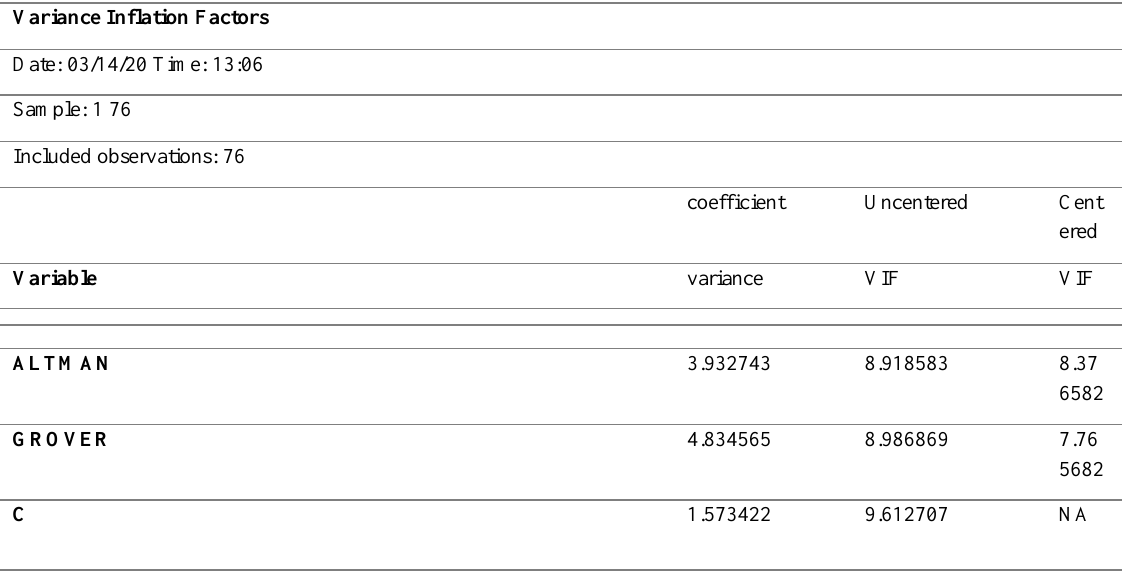
Table 4 : Multicollinearity Test